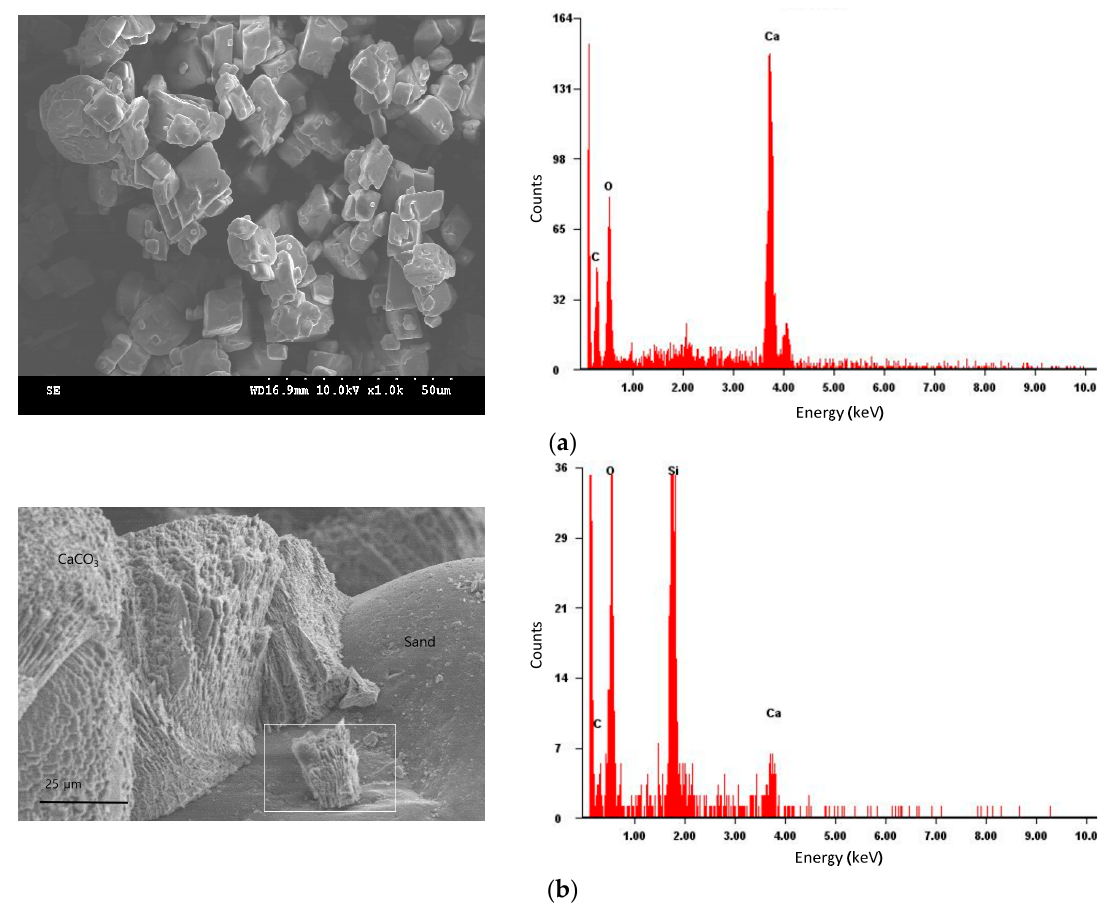
Figure 7. SEM and EDS analyses of ( a ) calcium carbonate powder; and ( b ) crystalline substances on silicate sand grains.